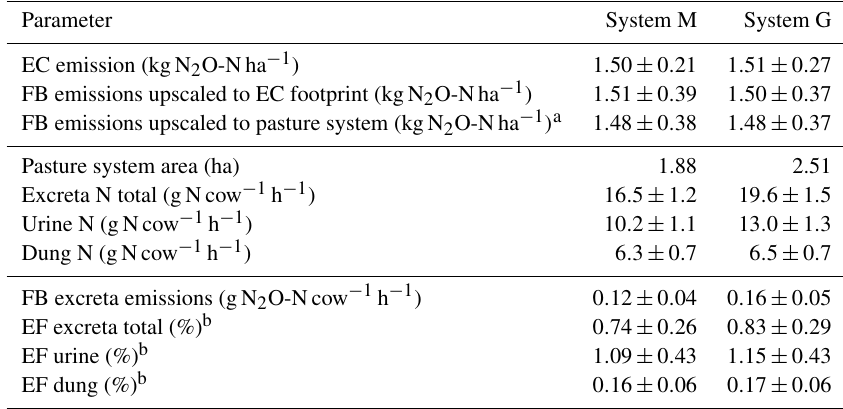
Table 5. Summary of cumulated grazing-related emissions for both pasture systems during the GOP 2016. The table shows the emissions per area (first part), pasture area, excreta N input (second part), and the emissions per cow and grazing hour as well as the calculated EFs (third part). The uncertainties are given as 1 σ